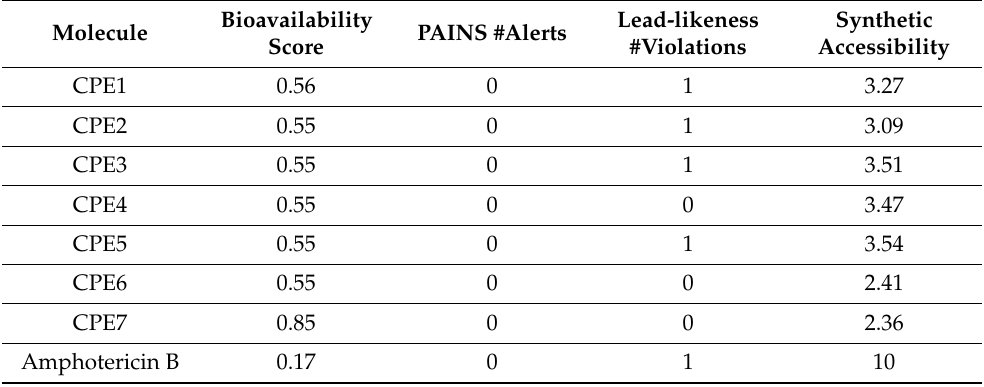
Table 3. Medicinal chemistry properties of selected and reference compounds. Bioavailability score: Probability of a compound to have bioavailability > 10% in a rat model. PAINS: Pan assay interference compounds (promiscuous compounds or potentially problematic fragments). Lead- likeness: Molecular suitability for optimization (small size and less hydrophobicity are